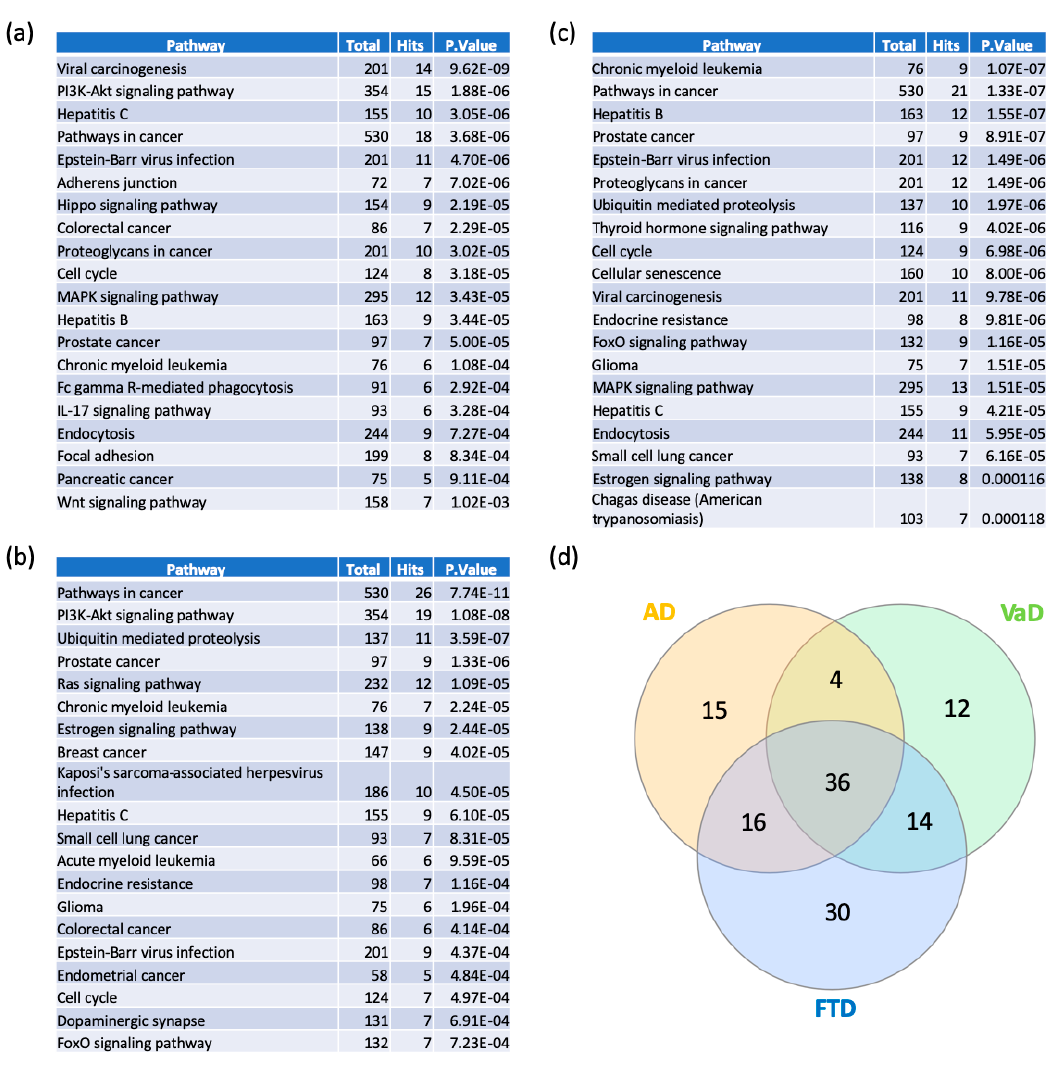
Figure 6. Pathway analyses of switch genes of AD, VaD and FTD patients. Pathway analysis was performed using NetworkAnalyst on tissue-specific networks derived from the protein-protein interaction database from the frontal cortex. The minimum connected network was selected for further pathway analysis. Results from the pathway analysis are derived from the Kyoto Encyclopedia of Genes and Genome (KEGG). Totals refers to the total number of genes that are known to be involved in the KEGG pathway and hits refers to the number of genes identified in this analysis that are involved in the pathway. The 20 top dysregulated pathways ranked according to the p -value are presented in the table. ( a ) AD pathways, ( b ) VaD pathways, ( c ) FTD pathways, and ( d ) Venn diagram analysis of the dysregulated pathways in AD, VaD and FTD.